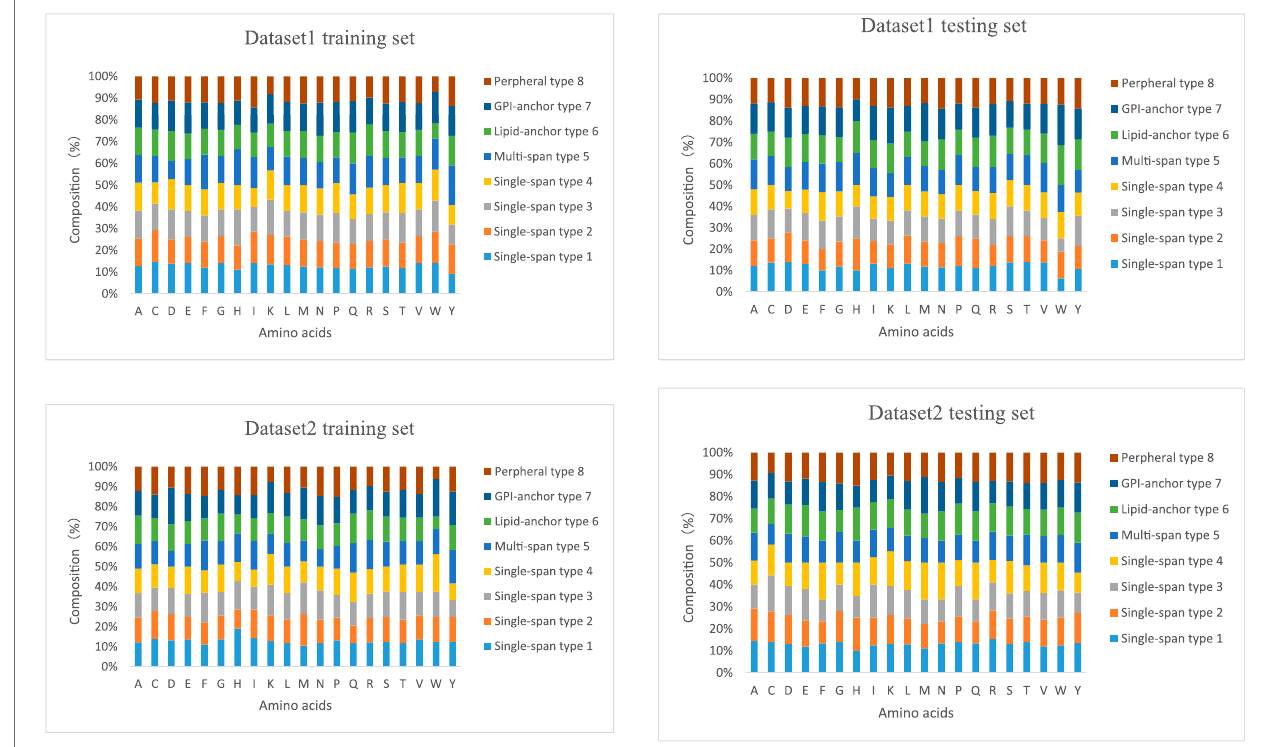
FIGURE 7 | Component composition of the training and test sets of the two datasets.